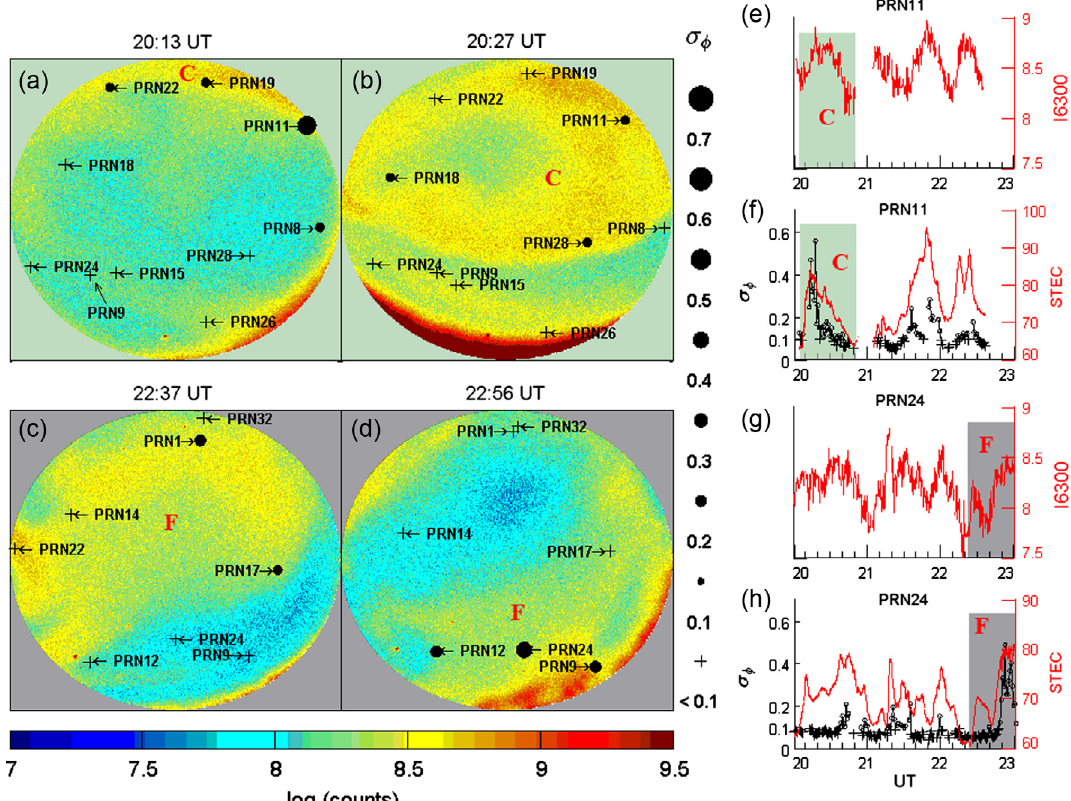
Fig. 2. (a–d) A sequence of images from the ASIP at channel 630.0 nm showing the observation of two polar cap patches (patches C and F). The black circles and plus signs indicate the locations of GPS satellites. The size of the circles relates to the r / strength showing on the right of the all-sky images, whereas black plus signs mean no scintillation was observed ( r / < 0.1). (a, b) Patch C came into the FOV and continued to move southward. The scintillation was observed when the patch passed through the line of sight (LOS) of several satellites. (c, d) Patch F entered into the LOS of PRN12 and PRN24, and enhanced phase scintillations were observed. (e) The temporal variation of optical emission at 630.0 nm channel corresponding to the locations of PRN11 in units of log (counts). (f) r / (black) and the Slant TEC (red line) from PRN11. r / are plotted as black circles when r / > = 0.1, otherwise as plus signs. The shaded regions in (e, f ) correspond to the time period when patch C passed through the LOS of PRN11. The data gap from 20:50 UT to 21:05 UT in (e, f) is due to loss of lock; PRN11 moved out of the FOV at 22:35 UT, therefore there is no data after this time. (g, h) The same format as (e, f) but for PRN24. The shaded regions show the pass of patch